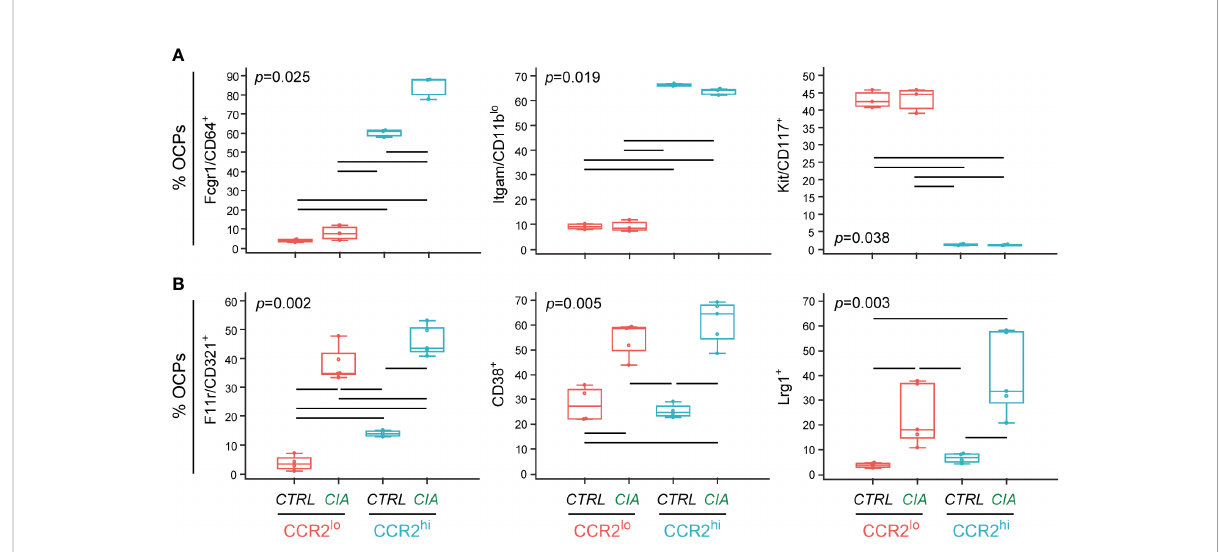
FIGURE 6 Validation of differentially expressed genes in osteoclast progenitor (OCP) subsets by fl ow cytometry. OCPs were fi rst identi fi ed in control (CTRL) mice and mice with collagen-induced arthritis (CIA) by phenotyping CCR2 hi and CCR2 lo subsets. Then, the additional markers of OCP subsets and interventions were included into the screening antibody panels for protein-level validation. (A) Membrane expression of Fcgr1/ CD64, Itgam/CD11b and Kit/CD117, presented as the percentage of immediate parent CD115 + CCR2 lo and immediate parent CD115 + CCR2 hi subsets (n=3 for both CTRL and CIA). (B) Membrane expression of F11r/CD321 and CD38, and intracellular expression of Lrg1, presented as the percentage of immediate parent CD115 + CCR2 lo and immediate parent CD115 + CCR2 hi subsets (n=4 for CTRL and n=5 for CIA). Individual values are presented; colored horizontal lines represent the median, boxes represent the interquartile range (IQR) and whiskers represent 1.5 times the IQR. Statistically signi fi cant difference (represented by black horizontal lines) was determined at p<0.05, Kruskal – Wallis test followed by Conover test for group-to-group